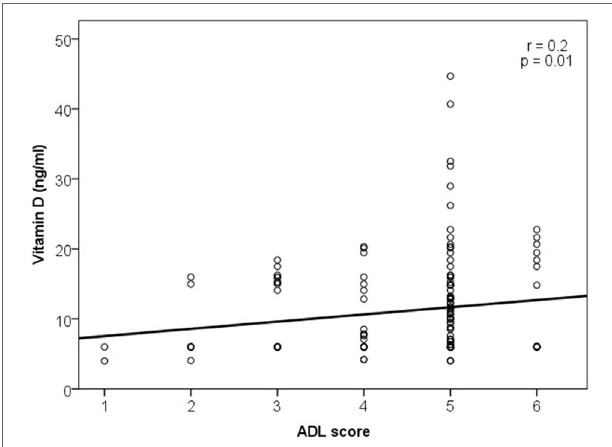
FigUre 1 | Association of vitamin D level with activities of daily living